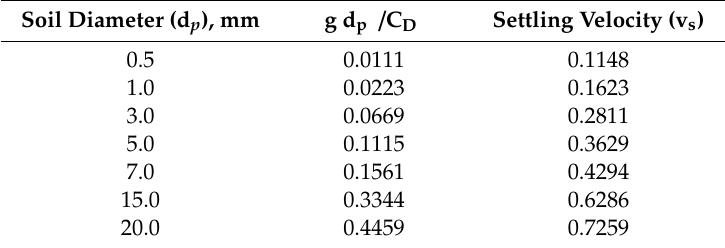
Table 3. Settling velocity by particle size.